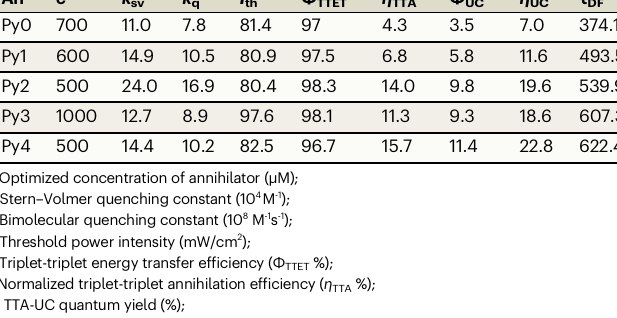
and Py3 via DFT//B3LYP/6-31G; c Electron density maps of the frontier molecular orbitals of Py1 and Py3; d Spin density surfaces of Py1 and Py3 in toluene at the optimized triplet state geometries.